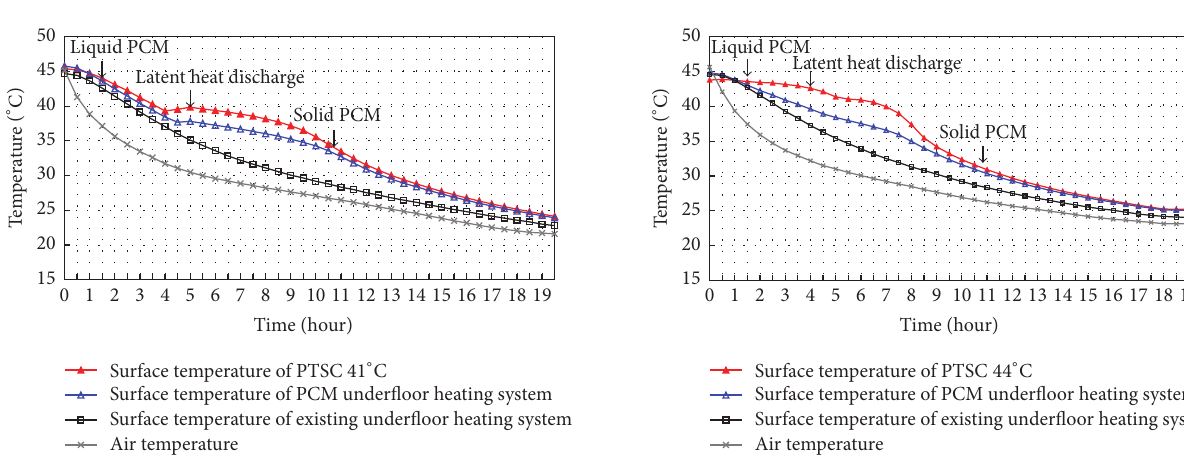
Figure 9: Surface temperatures of existing underfloor heating system and PUFHS with PTSC 41 ∘ C.